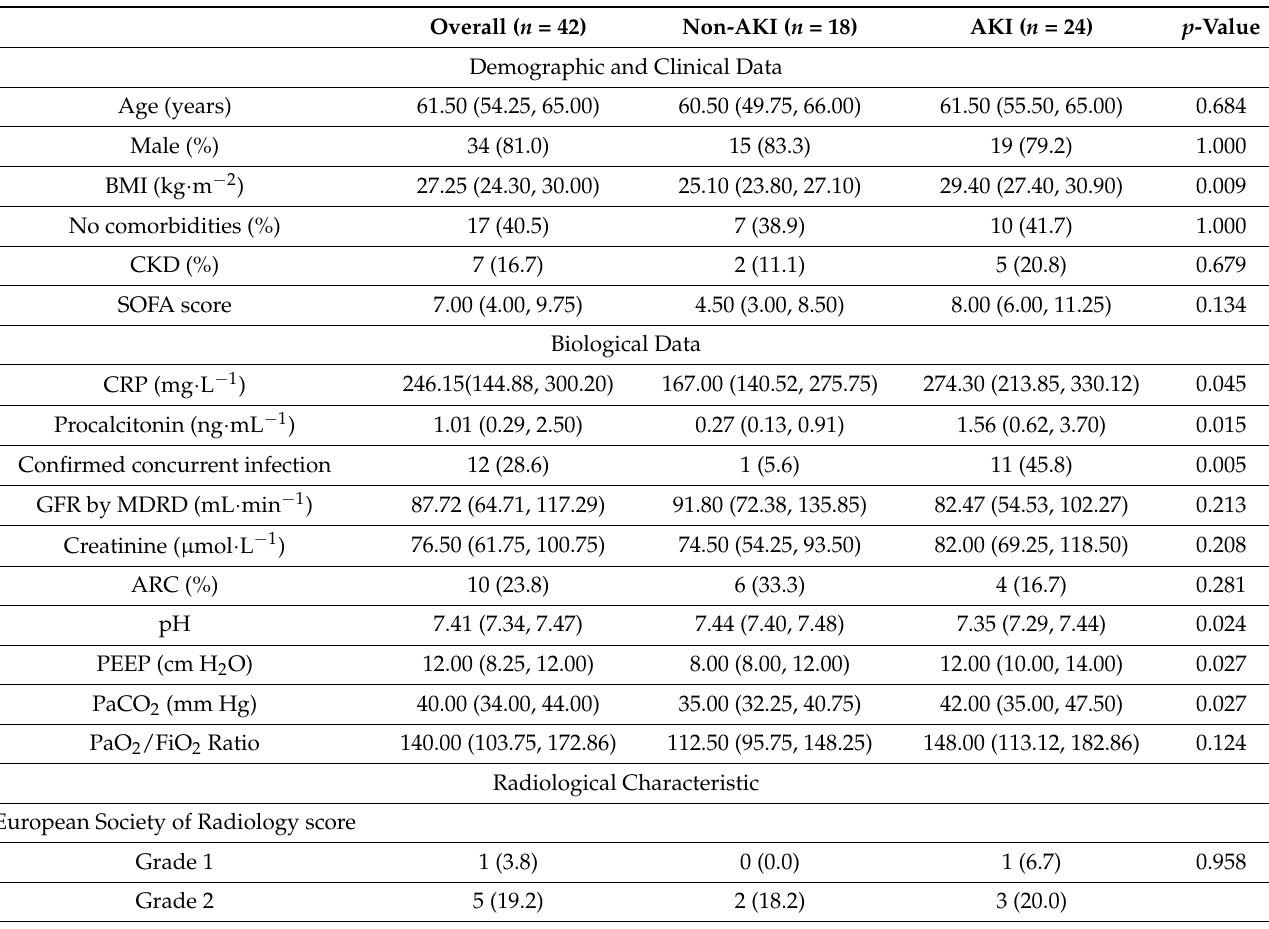
Table 1. Baseline and ICU admission patient’s